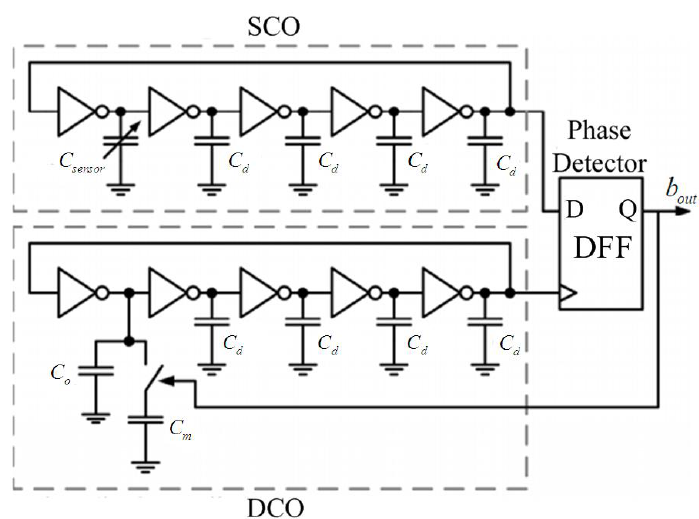
Figure 3. Proposed fully-digital capacitive sensor